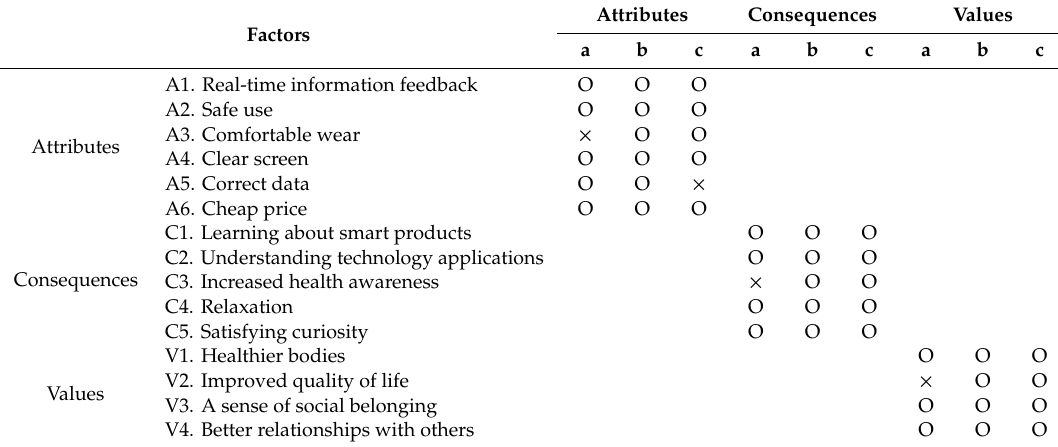
Table 3. Coding of factors.